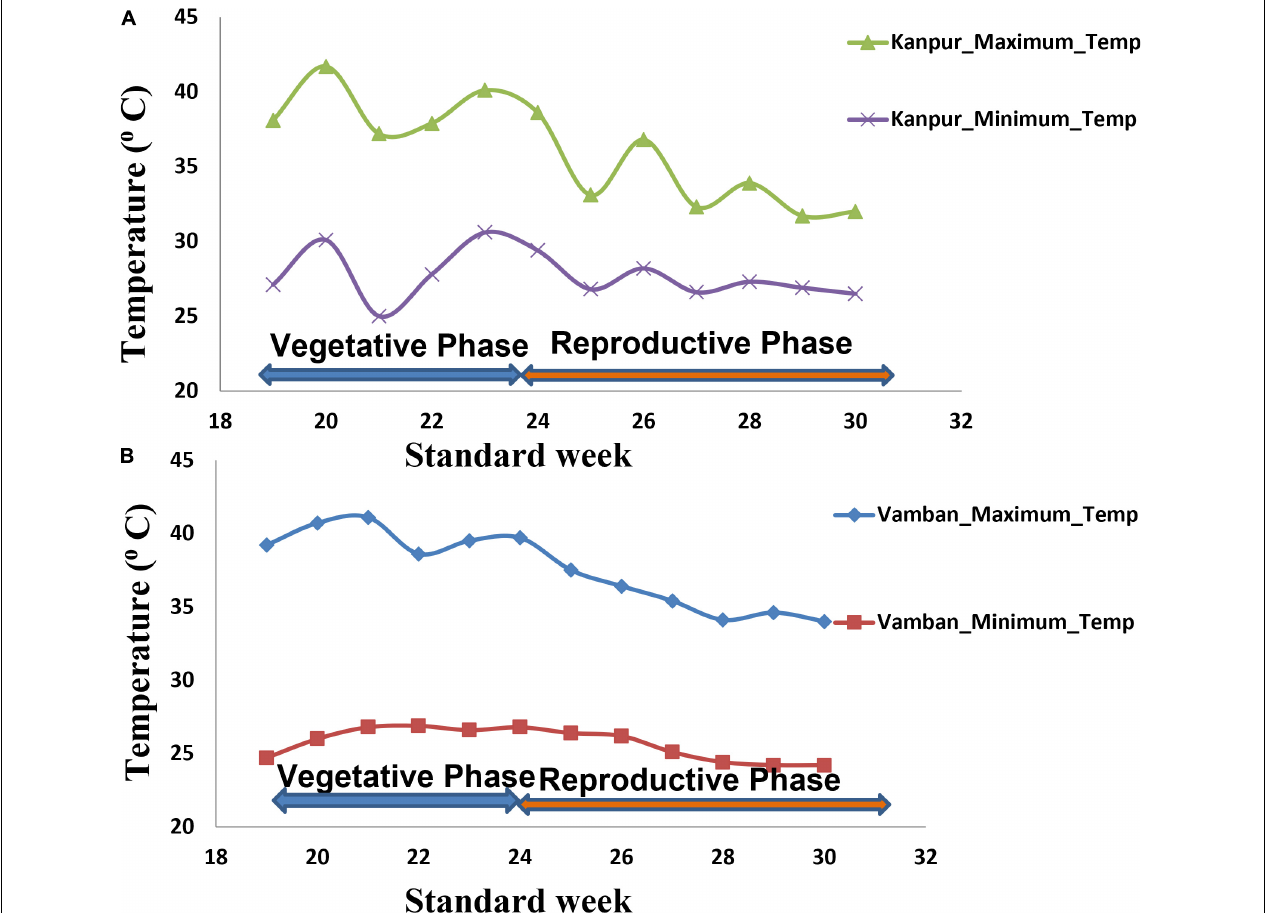
FIGURE 1 | Temperature regime at two field trial sites during crop growth period (Kanpur and Vamban). (A) Temperature regime at the Kanpur location. (B) Temperature regime at the Vamban